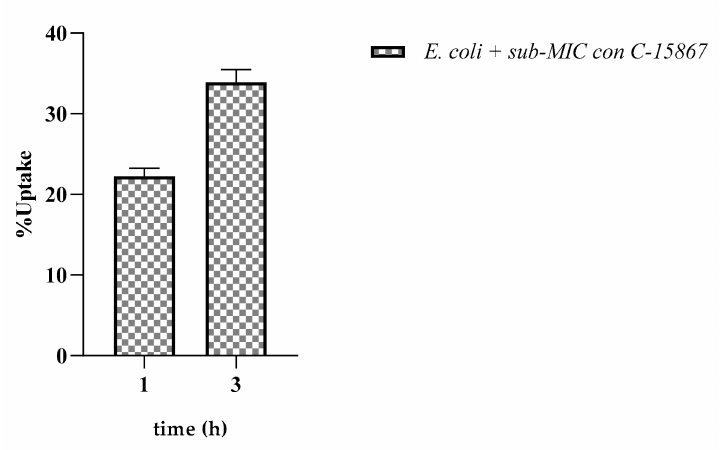
Figure 6. Effect of C-15867 on E. coli BL 21 membrane permeability. The uptake of crystal violet was calculated in the presence of sub-mic concentration (9 µ M) of the